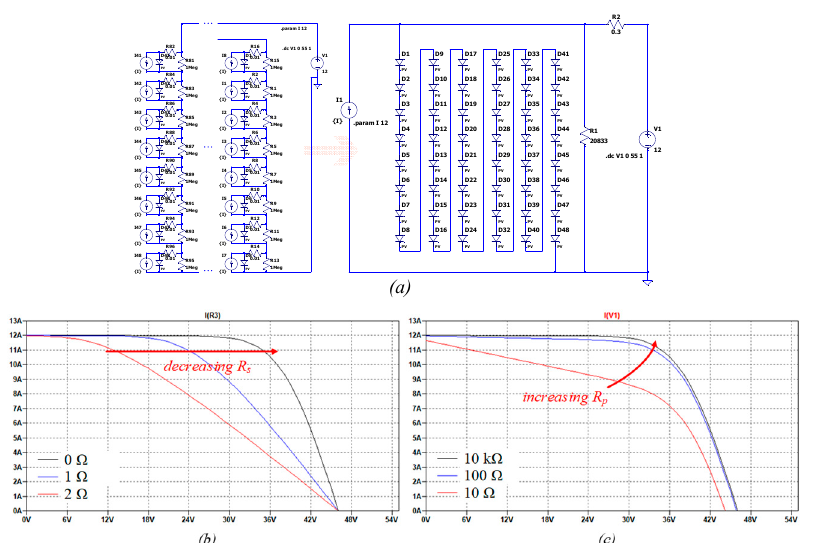
Figure 10. ( a ) Equivalent conversion of the PVE model in LTspice; ( b ) Simulation results of I–V properties with decreasing R s ; ( c ) Simulation results of I–V properties with increasing R p .